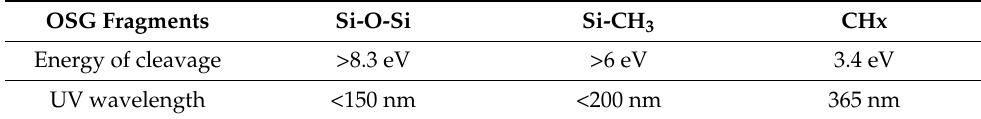
Table 3. The cleavage energy of low-k components